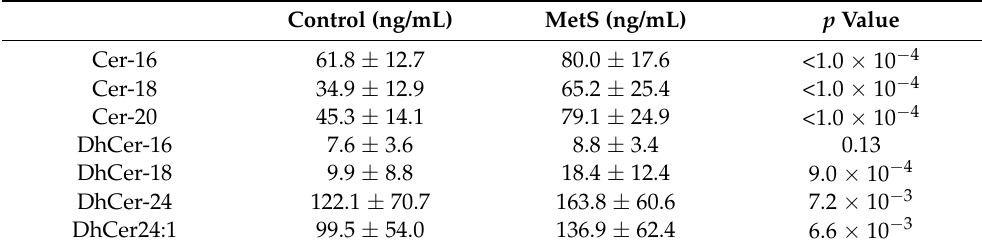
Values are shown as mean ±